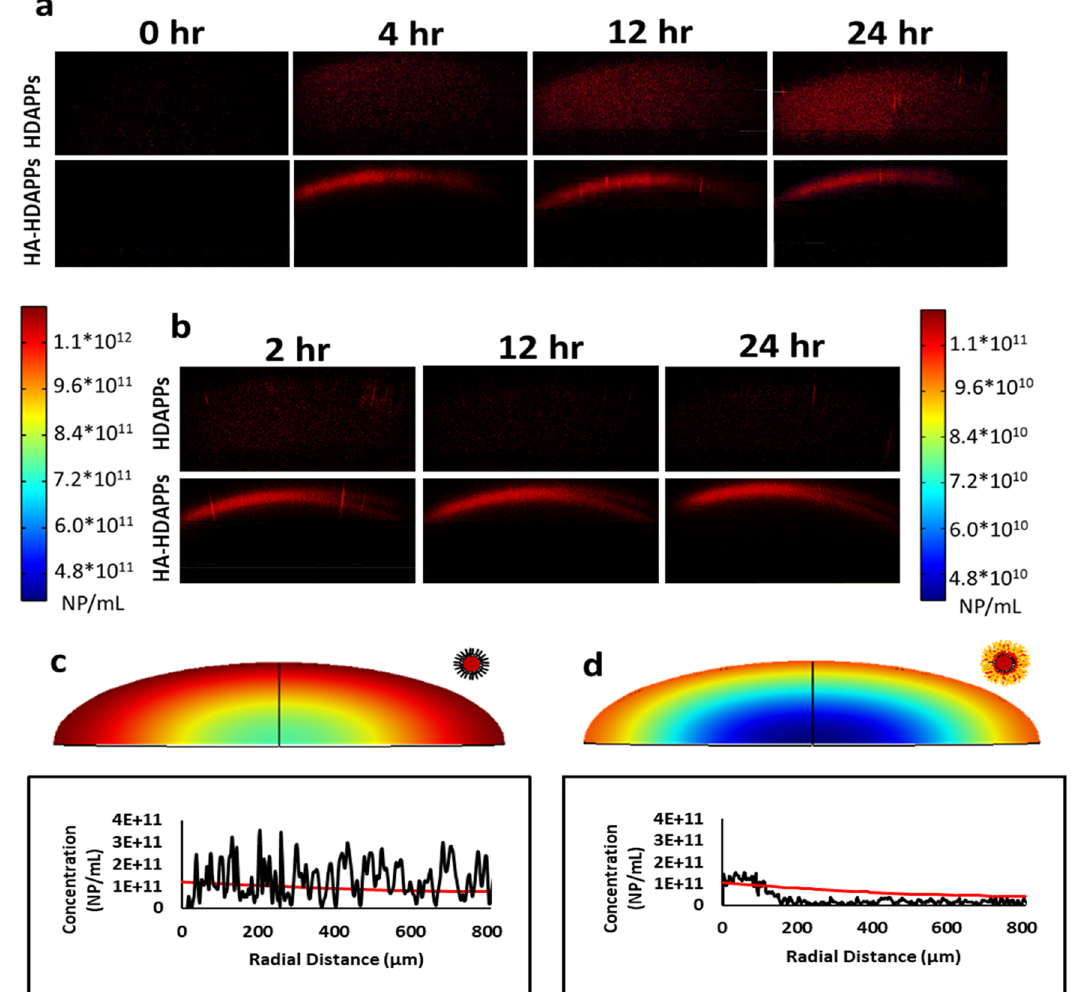
Figure 4. Experimental and computational diffusion profiles. ( a ) Experimental images of fluorescent HDAPPs and HA-HDAPPs diffusing into organoid matrices over a 24 h period and ( b ) experimental images of HDAPPs and HA-HDAPPs diffusing out of organoid matrices over a 24 h period. Computational profiles were calculated for concentration of HDAPPs ( c ) and HA-HDAPPs ( d ), with the red intensity indicating higher concentrations. The red lines indicate the calculated nanoparticle concentration in comparison to the experimentally measured profiles (black lines), measured spatially at 24 HA‑HDAPPs irreversibly sequester at organoid peripheries relative to freely diffusing HDAPPs. Unlike free movement in liquid, the tumor ECM microenvironment limits the efficacy of NP ther- apeutics by retarding transport processes such as diffusion to become the rate-limiting phenomenon 26 . The 3D